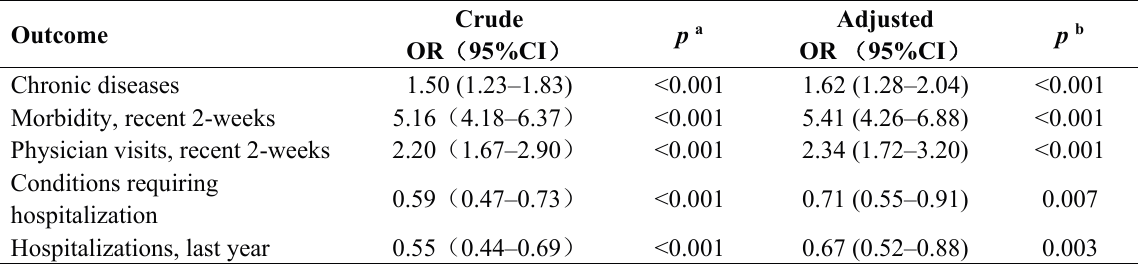
Table 3. Odds ratios of self-reported morbidity and health service utilization comparing Chinese rural-to-urban migrant workers vs. local urban